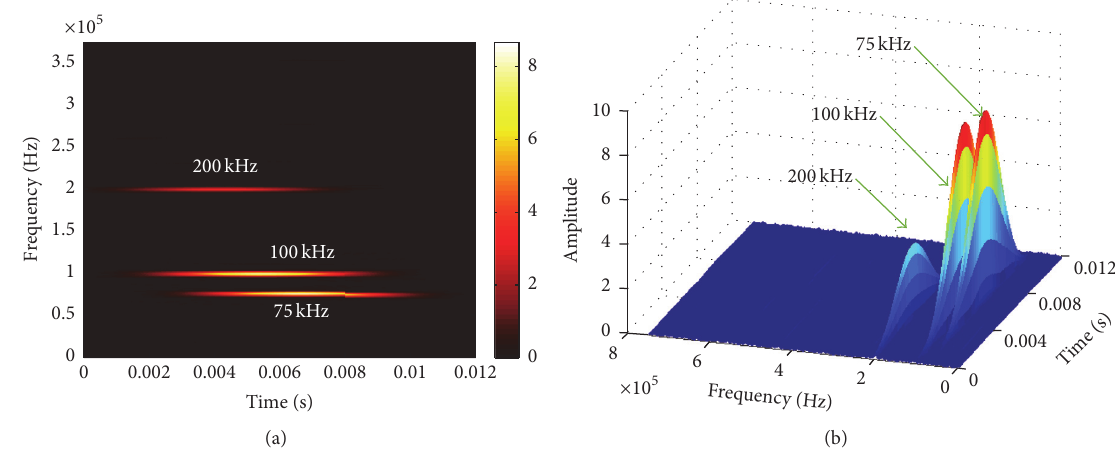
Figure 4: The STFT representation with a long window of the sample signal: (a) two-dimensional figure and (b) three-dimensional figure.